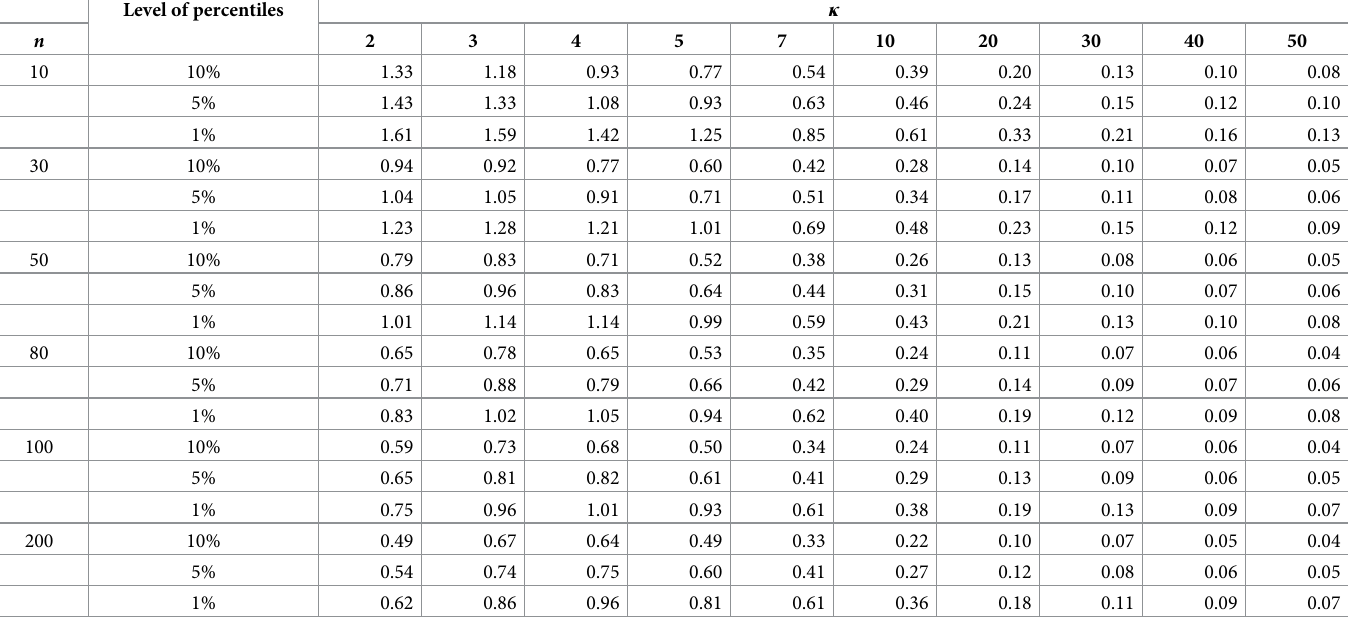
for Q 3 statistic. Q